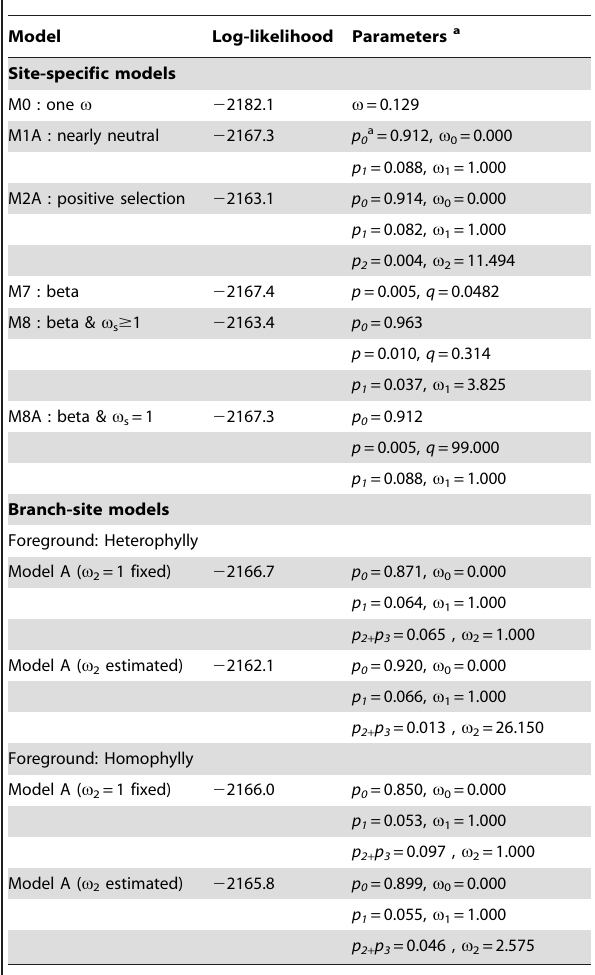
Table 1. Parameter estimates and log-likelihood values for Potamogeton rbcL under eight codon substitution models included in PAML.